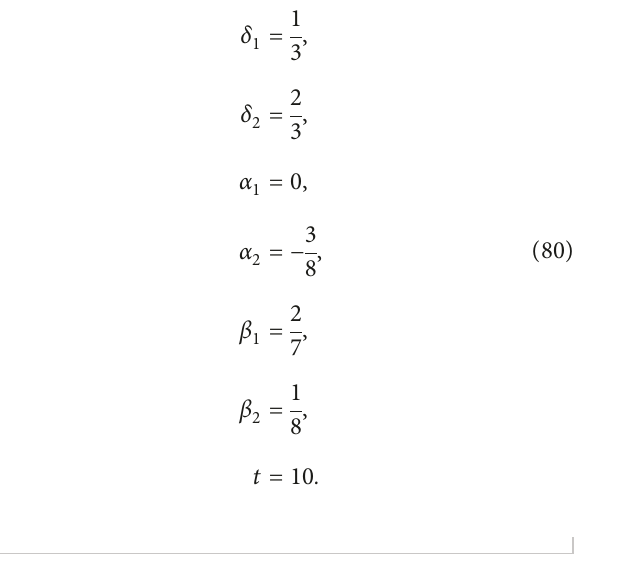
For Figure 18(a) ( t � − 10 ) , Figure 18(b) ( t � − 5 ) , Figure 18(c) ( t � 0 ) , Figure 18(d) ( t � 5 ) , and ( f 5) ( t � 10 ) . Also, Figure 18 shows two y -periodic breather.